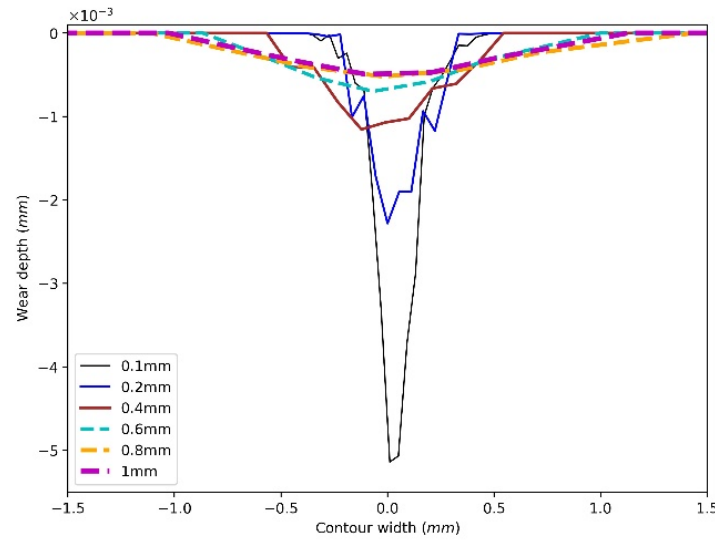
Figure 8. Effect of mesh size on wear contour.